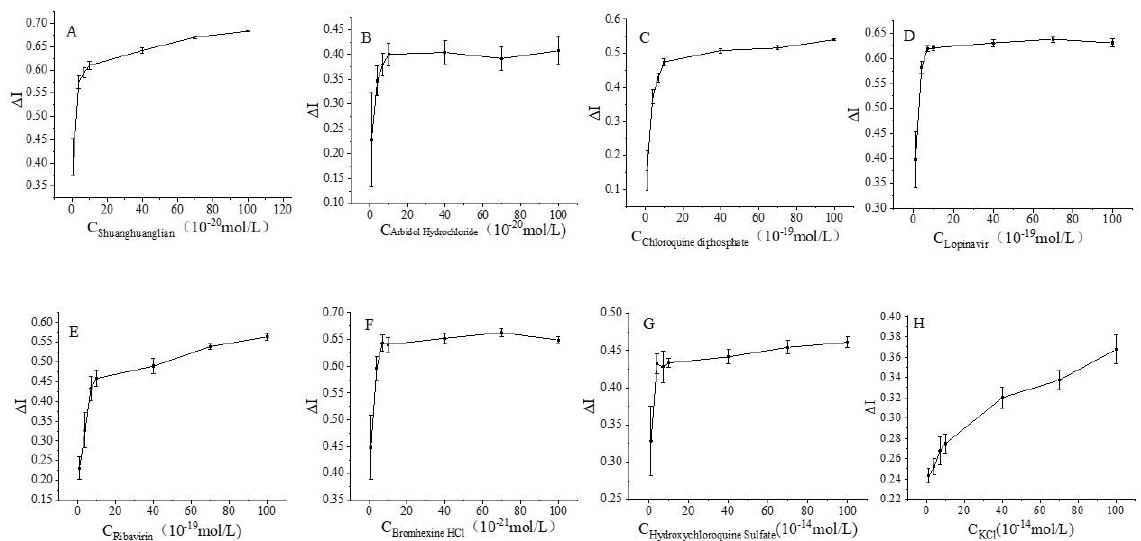
Figure 5. Variation of the rate of change of the response current as a function of drug concentration: ( A ) Shuanghuanglian oral liquid 10 − 20 –10 − 18 mol/L; ( B ) abridol 10 − 20 –10 − 18 mol/L; ( C ) chloroquine diphosphate 10 − 19 –10 − 17 mol/L; ( D ) lopinavir 10 − 19 –10 − 17 mol/L; ( E ) ribavirin 10 − 19 –10 − 17 mol/L; ( F ) bromhexine 10 − 21 –10 − 19 mol/L; and ( G ) hydroxychloroquine 10 − 14 –10 − 12 mol/L; ( H ) KCl 10 − 15 – 10 − 13 mol/L as control.